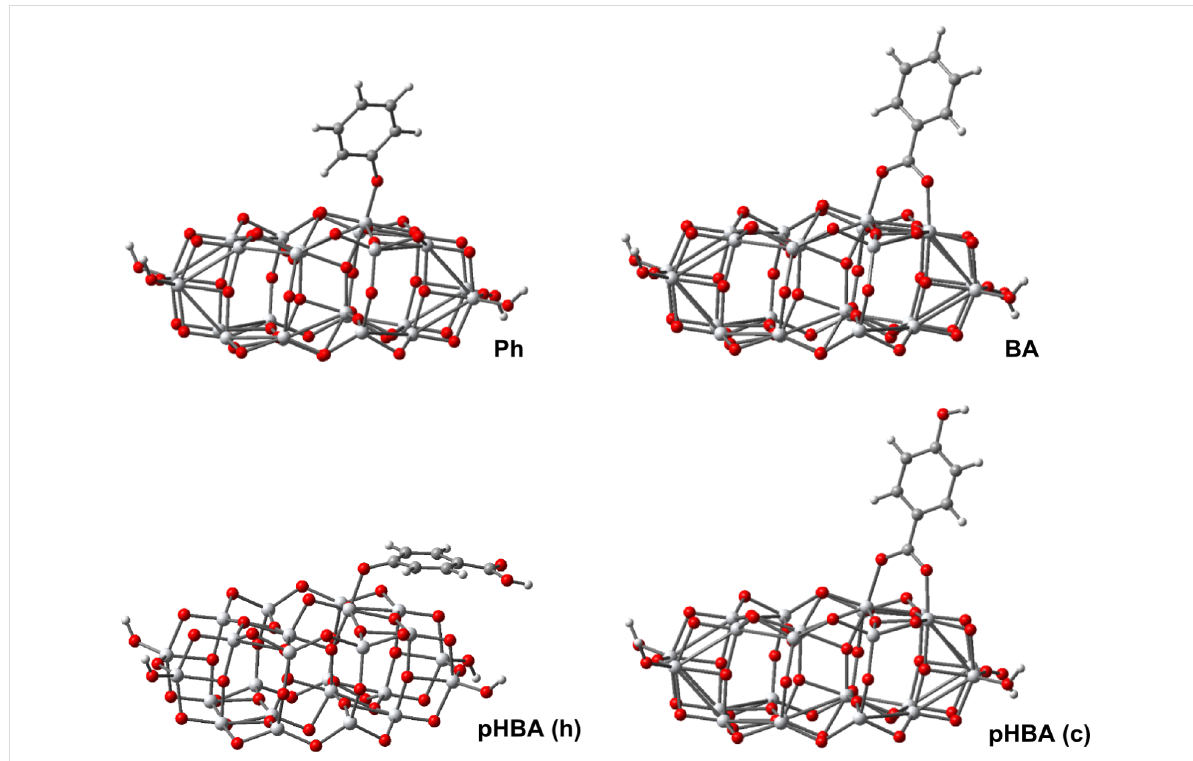
Figure 5: Optimized geometry of the pollutant-catalyst systems calculated at DFT/B3LYP/3-21G* level; pHBA is anchored either through the hydroxy (h) or the carboxy (c) groups.